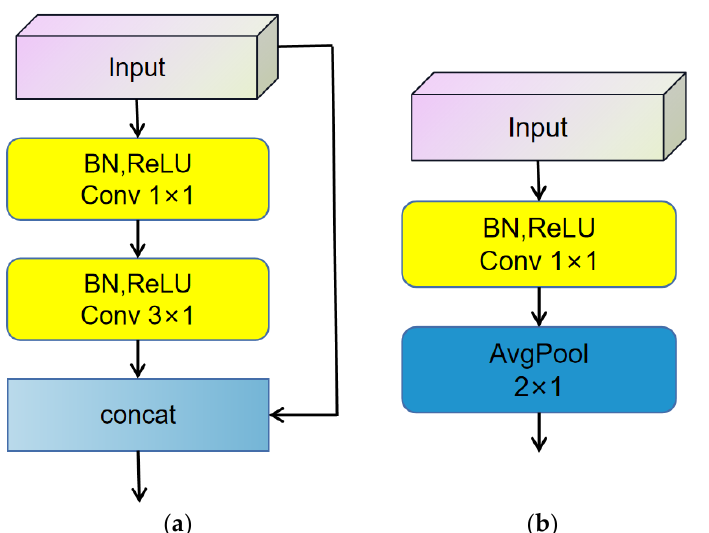
Figure 5. Structure of dense blocks and translation layers. ( a ) Denseblock structure. ( b ) Transition structure.